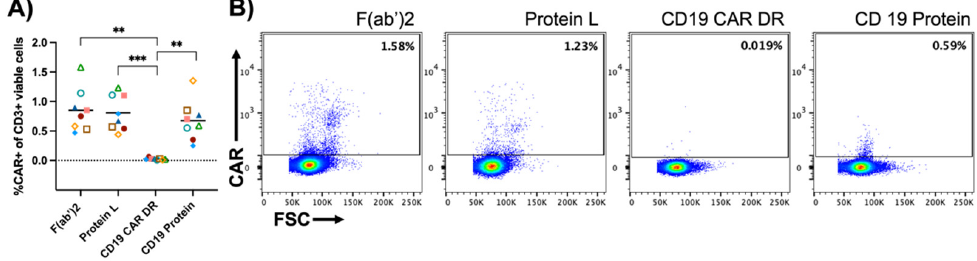
Figure 4. Specificity of the different detection reagents. PBMCs were stained with the respective CAR-detecting reagents to assess background staining. ( A ) shows the percentage of CD19.CAR-T cells in PBMCs only, for eight different donors. ( B ) displays results from one donor stained with different detection reagents. Data are representative of eight different HDs acquired in one experiment. (**) p < 0.01; (***) p < 0.001 by one-way ANOVA.